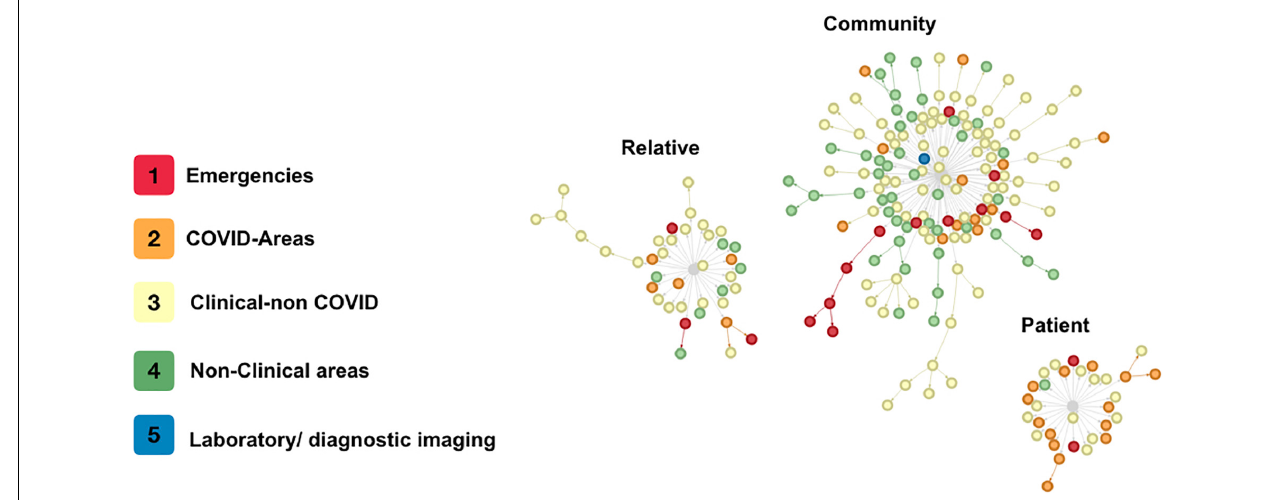
FIGURE 3 | Contagion clusters. Every circle is a single health personnel with COVID-19. The colors indicate the area where each health personnel worked. The lines are the direction of contagion between contacts. The gray center is the type of source but not a single case of contagion.